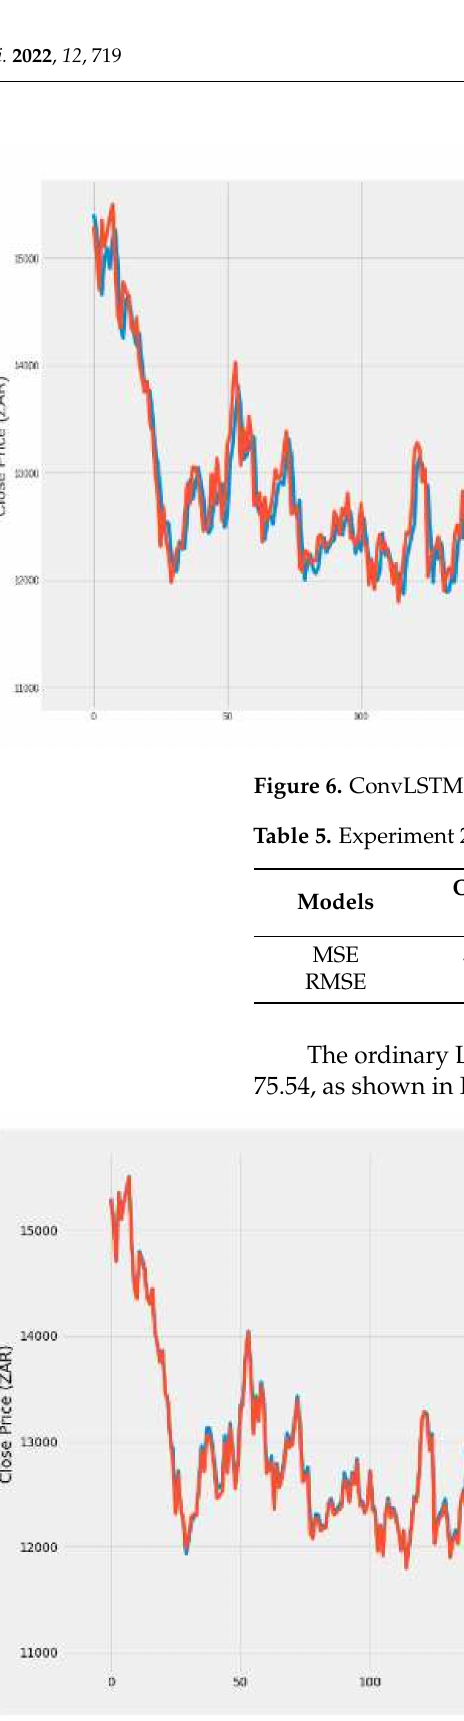
Figure 7. Ordinary LSTM Experiment